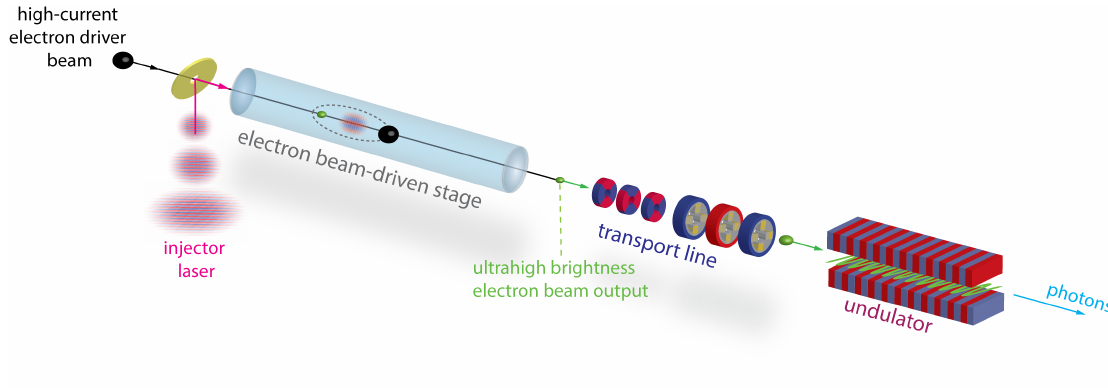
Figure 13. Schematic of an undulator-based FEL driven by the output of a hybrid plasma accelerator based on LWFA electron beams, with a plasma photocathode PWFA stage as beam brightness